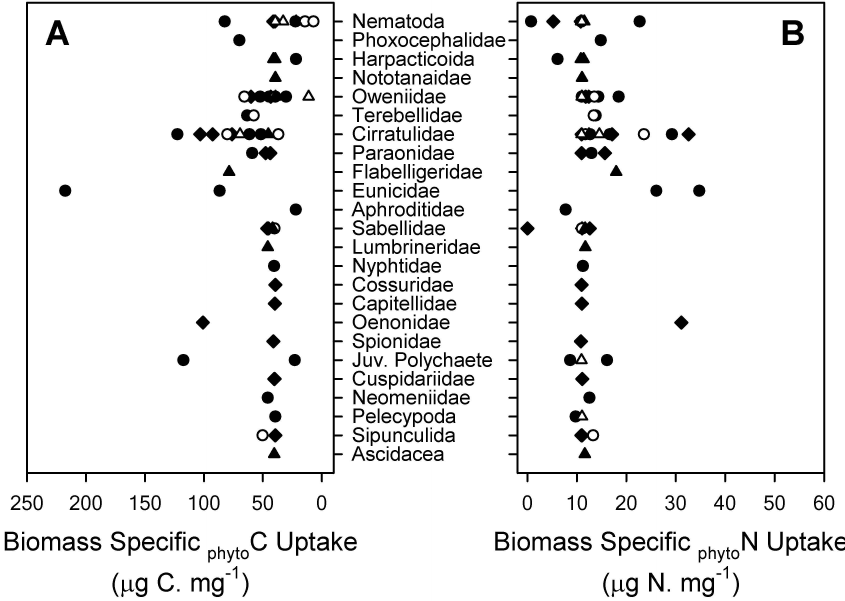
Fig. 6. Biomass specific assimilation of phyto C and phyto N by individual macrofaunal taxa at stations T1 800m (4 day, (cid:7) ) , T2 800m (4 day • , 7 day ◦ ) and T2 1100m (4 day N , 7 day 4 ).